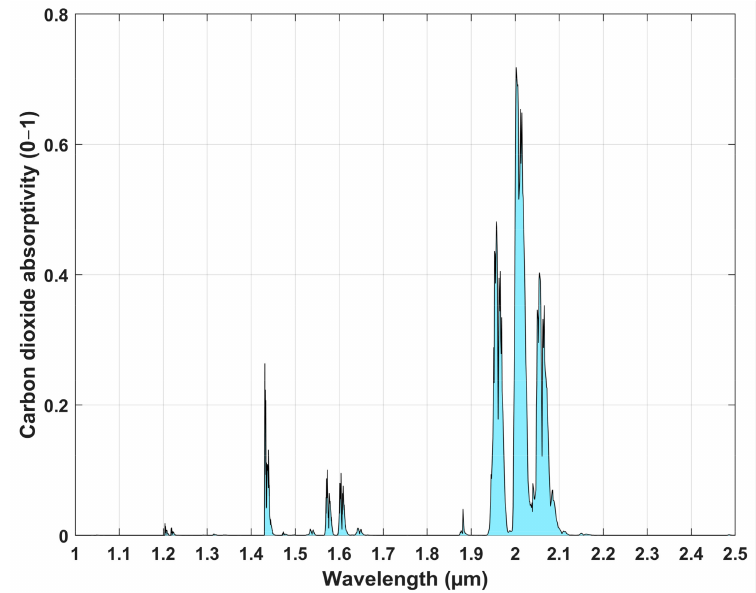
Figure 1. Carbon dioxide absorption bands in the SWIR spectral